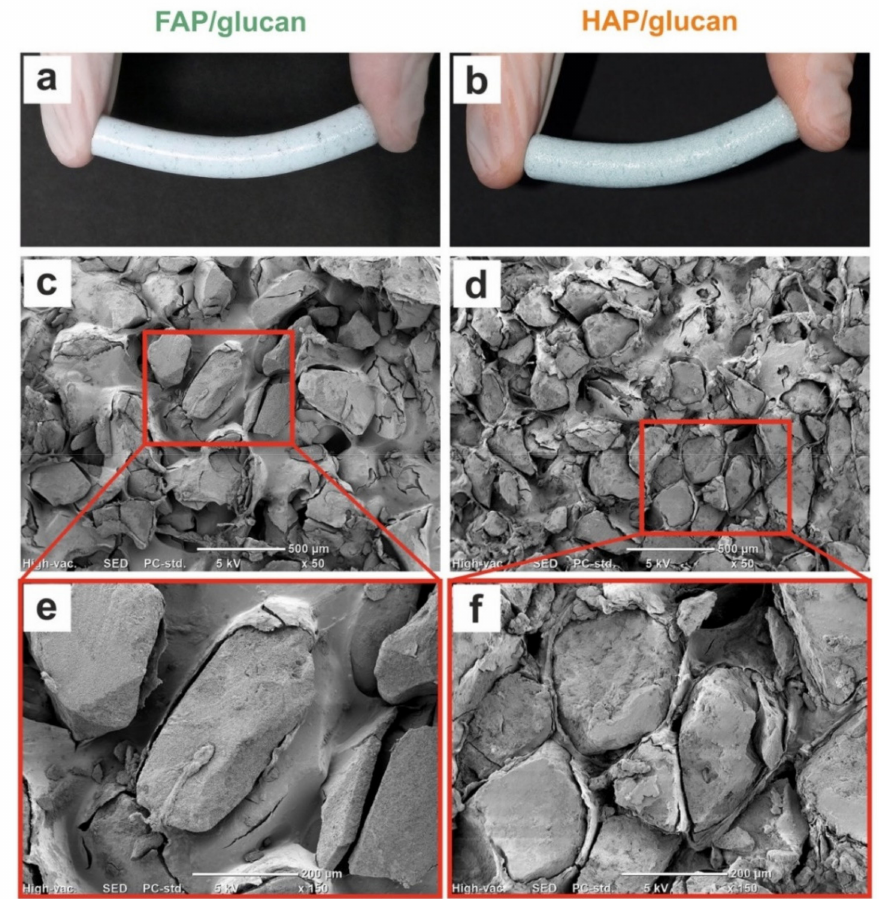
Figure 1. Panels ( a , b ) show macroscopic images of FAP/glucan and HAP/glucan after squeezing in fingers. Panels ( c , d ) show SEM images of the surface of materials magnified 50 × . Panels ( e , f ) show SEM images of magnified fragments of composites surface (marked with a red frame on panels c , d